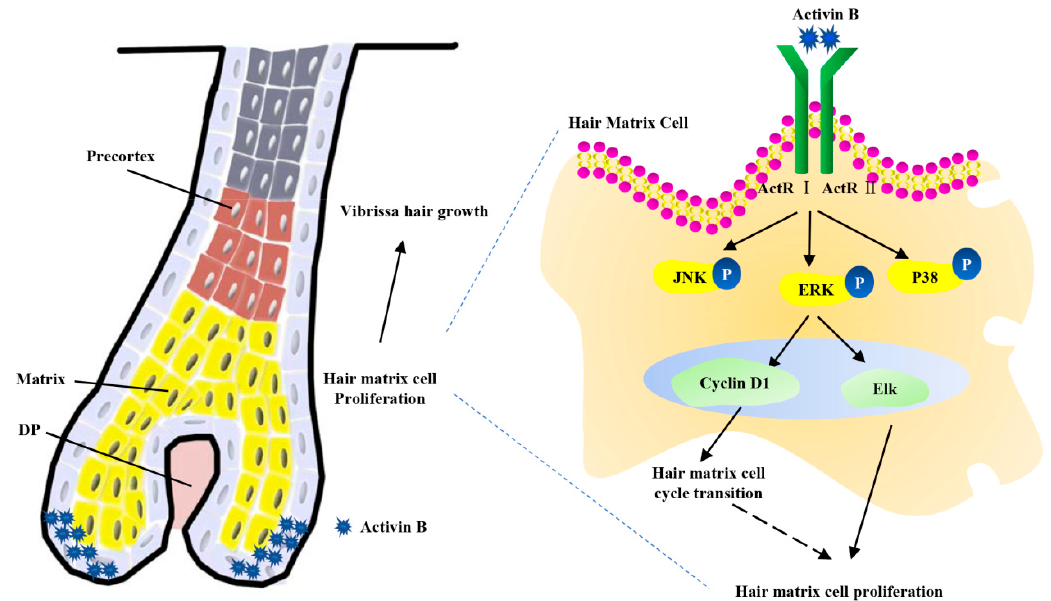
Figure 6. The proposed mechanisms model of Activin B on mouse vibrissae growth. Activin B accelerates vibrissae follicle growth. Activin B modulates the cell growth of hair matrix cells through the ERK–Elk1 signaling pathway and accelerates hair matrix cell transition from the G0/G1 phase to the S phase through the ERK-Cyclin D1 pathway.